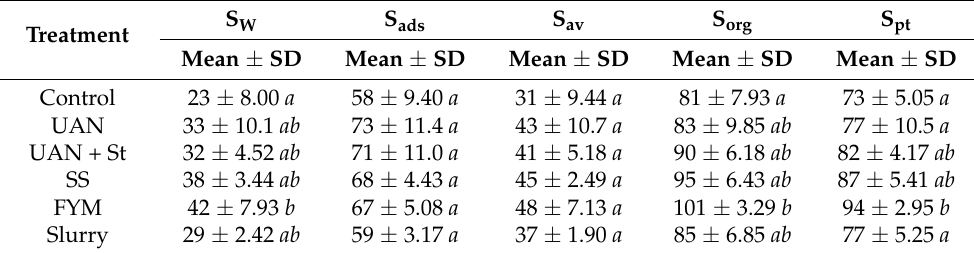
The different italic letters describe statistically significant differences between treatments per soil sulfur fraction. Tukey HSD test p < 0.05 ( n =